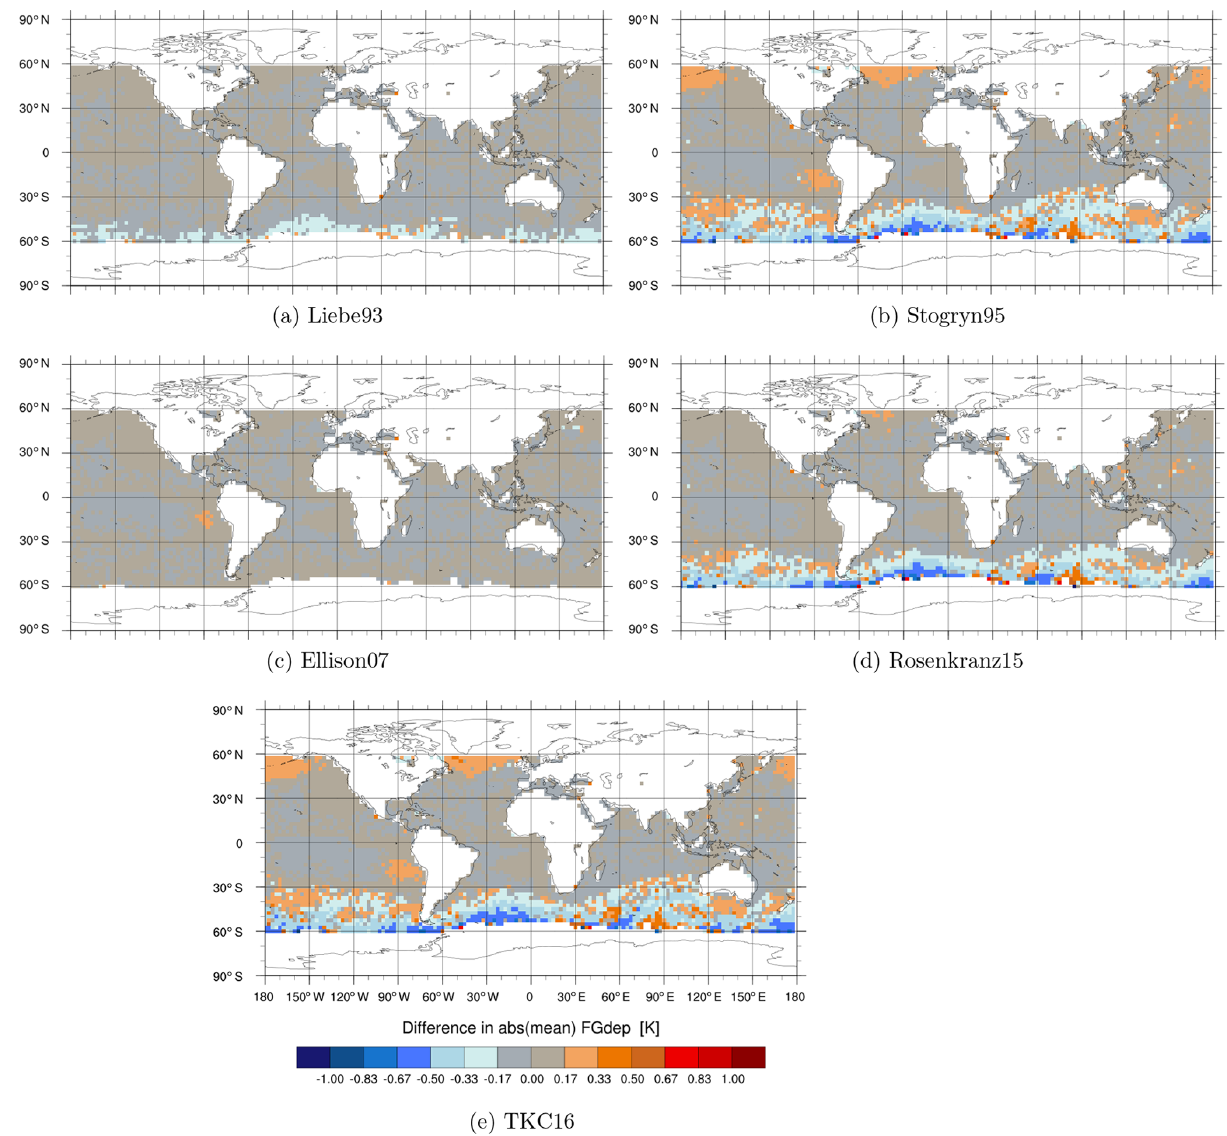
Figure A2. As in Fig. A1 but for channel